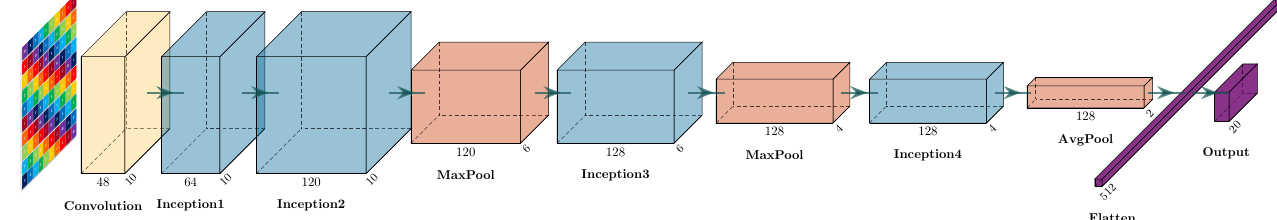
Figure 8. The overall architecture of Inception-CNN.